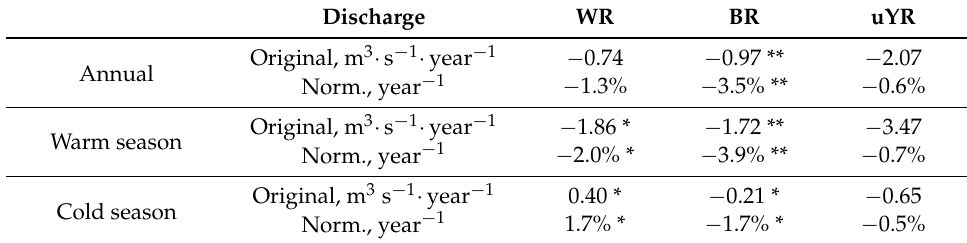
Table 6. River discharge trends from the Zoige basins and uYR from 1985 to 2007 at annual and seasonal scales (warm season, from May to September; cold season, from October to April). The slopes of original and normalized (Norm.) discharges are in m 3 s ´ 1 ¨ year ´ 1 and year ´ 1 , respectively.